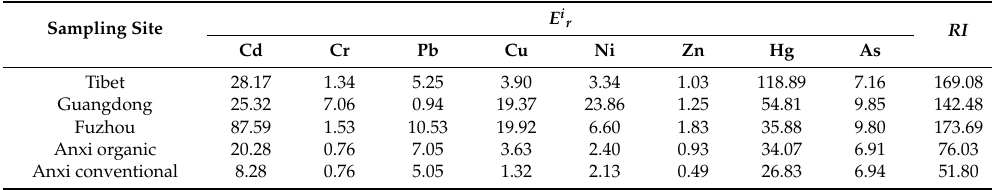
Table 3. Potential ecological hazard index ( E i r ) of each heavy metal and PERI ( RI ) values in soils of tea plantations in China.